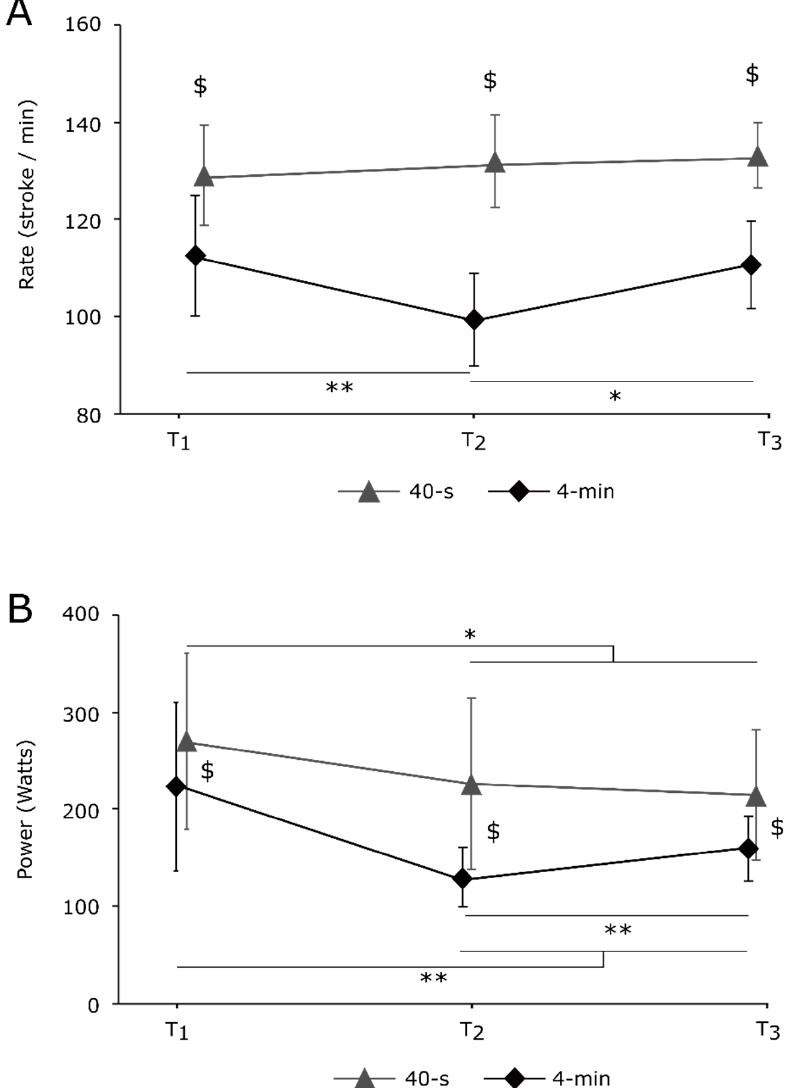
Figure 2. Stroke rate ( A ) and power ( B ) recorded during the 40 s and 4 min sprints (N = 9; mean ± SD). * denotes a significant difference between time points within condition, and $ difference between condition. One item ( p < 0.05) and two items ( p < 0.01).